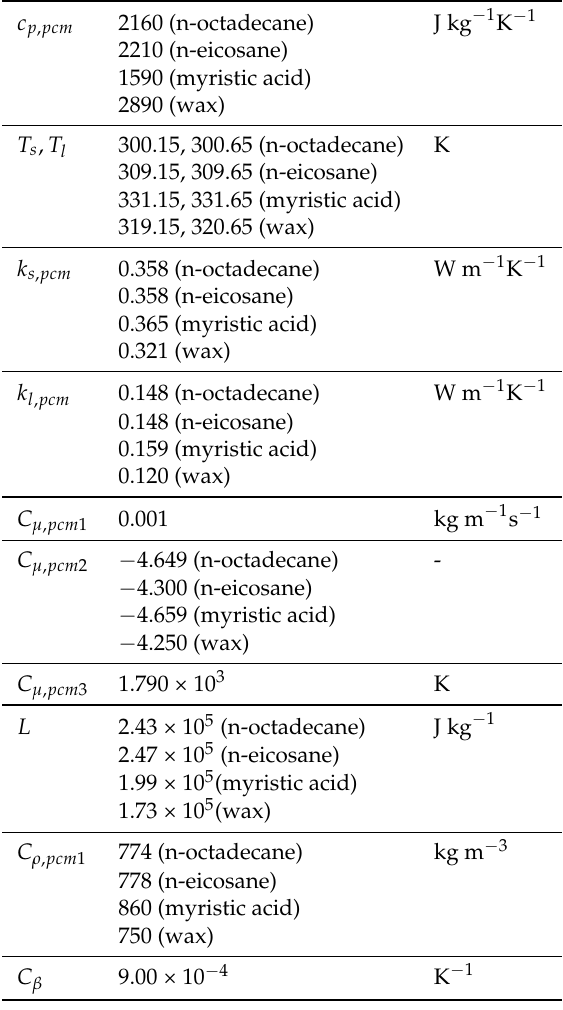
Table 3. Fitting constants for PCM material characteristic functions.